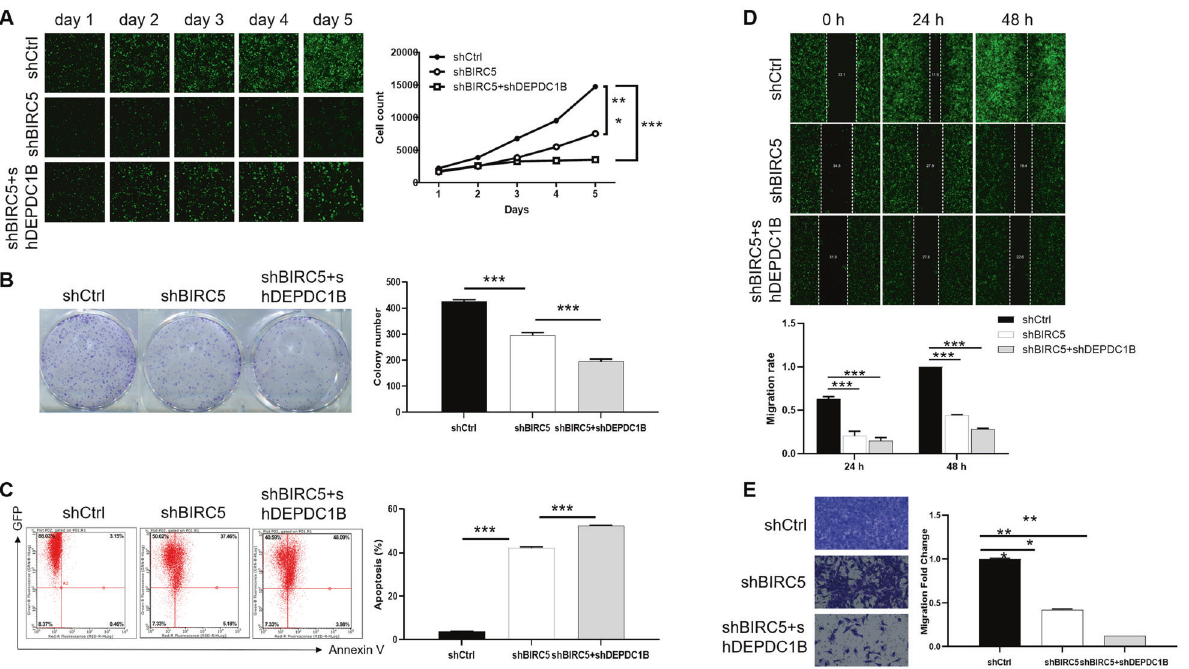
Fig. 5 Knockdown of BIRC5 deepens the effects on chordoma cells by DEPDC1B knockdown. After lentivirus shCtrl, shBIRC5 or shBIRC5 + shDEPDC1B infected with MUG-Chor1 cells, they were subjected to the detection of proliferation ( A ), clone formation ( B ), apoptosis ( C ) and migration ( D , E ). The presented results were representative of experiments repeated at least three times. Data were represented as mean ± SD. * P < 0.05, ** P < 0.01, *** P < 0.001.